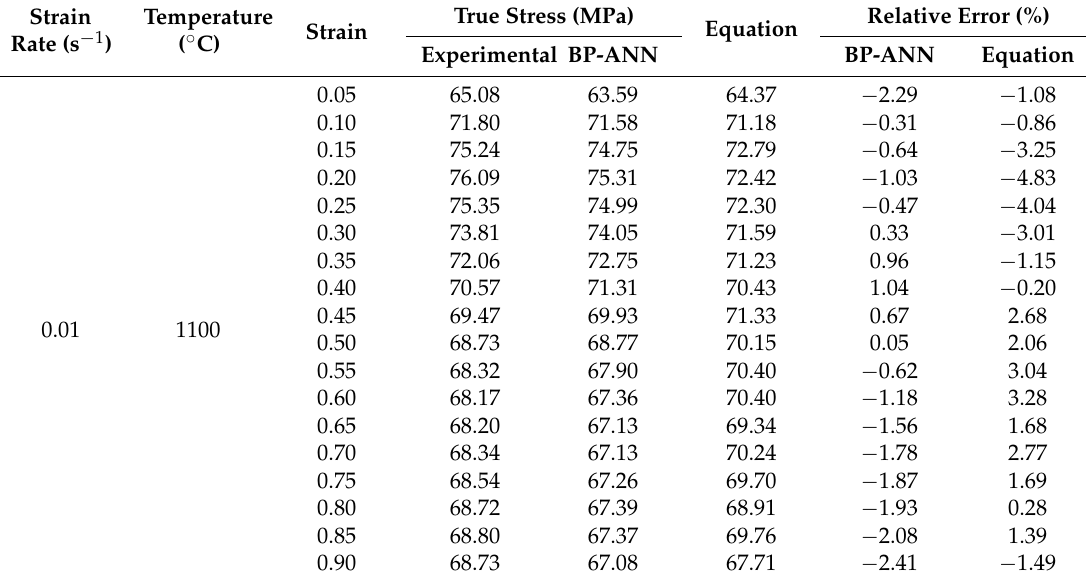
Table 2. Relative errors of the predicted results by the back ‐ propagational artificial neural network (BP ‐ ANN) model and constitutive equation to experimental results under the condition of 1100 °C and 0.01 s − 1 and 1200 °C and 1 s − 1 .